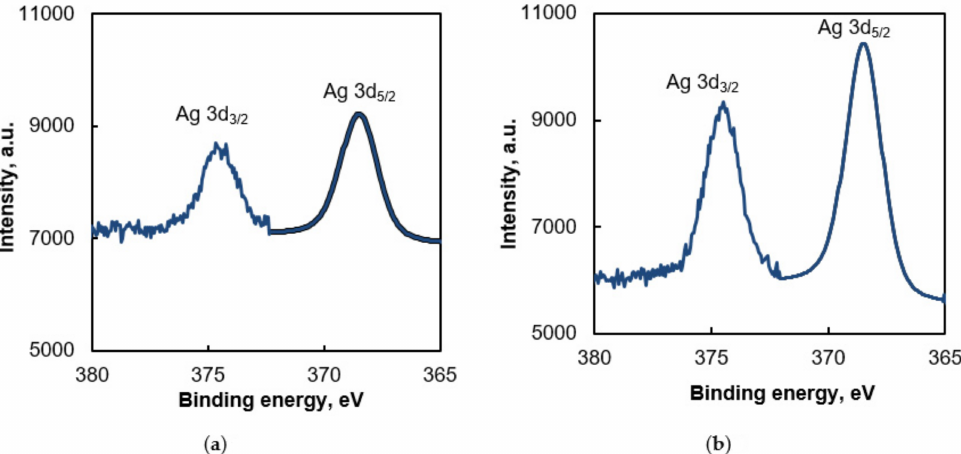
Figure10. High-resolution XPS spectra of the Ag 3d peak: ( a ) CF–Ag NP hybrid; ( b ) CFvap–Ag nanohybrid.